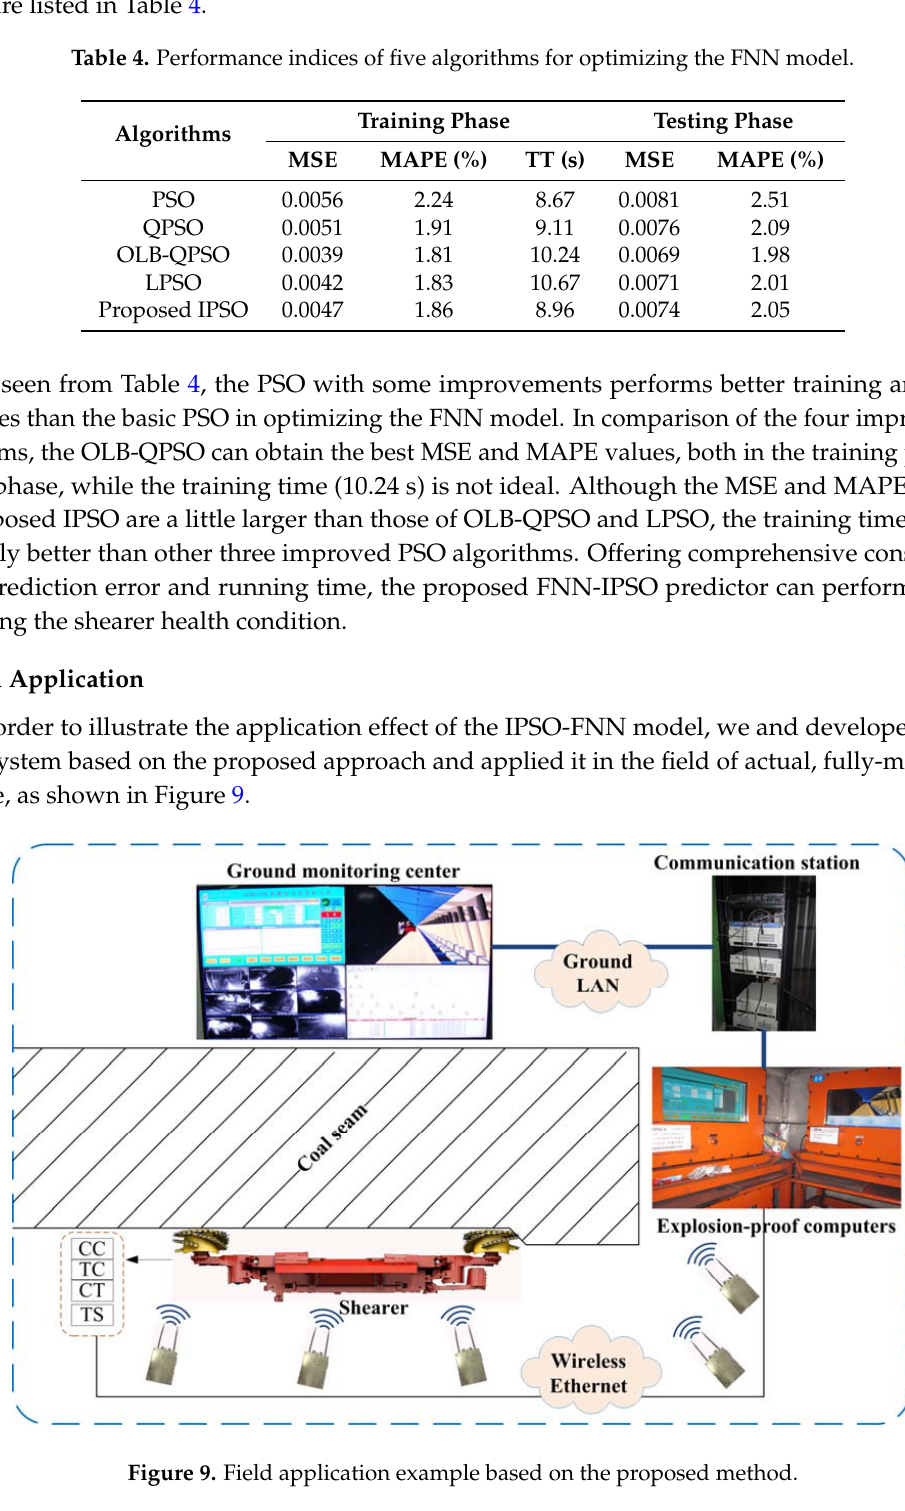
Table 4. Performance indices of five algorithms for optimizing the FNN model.